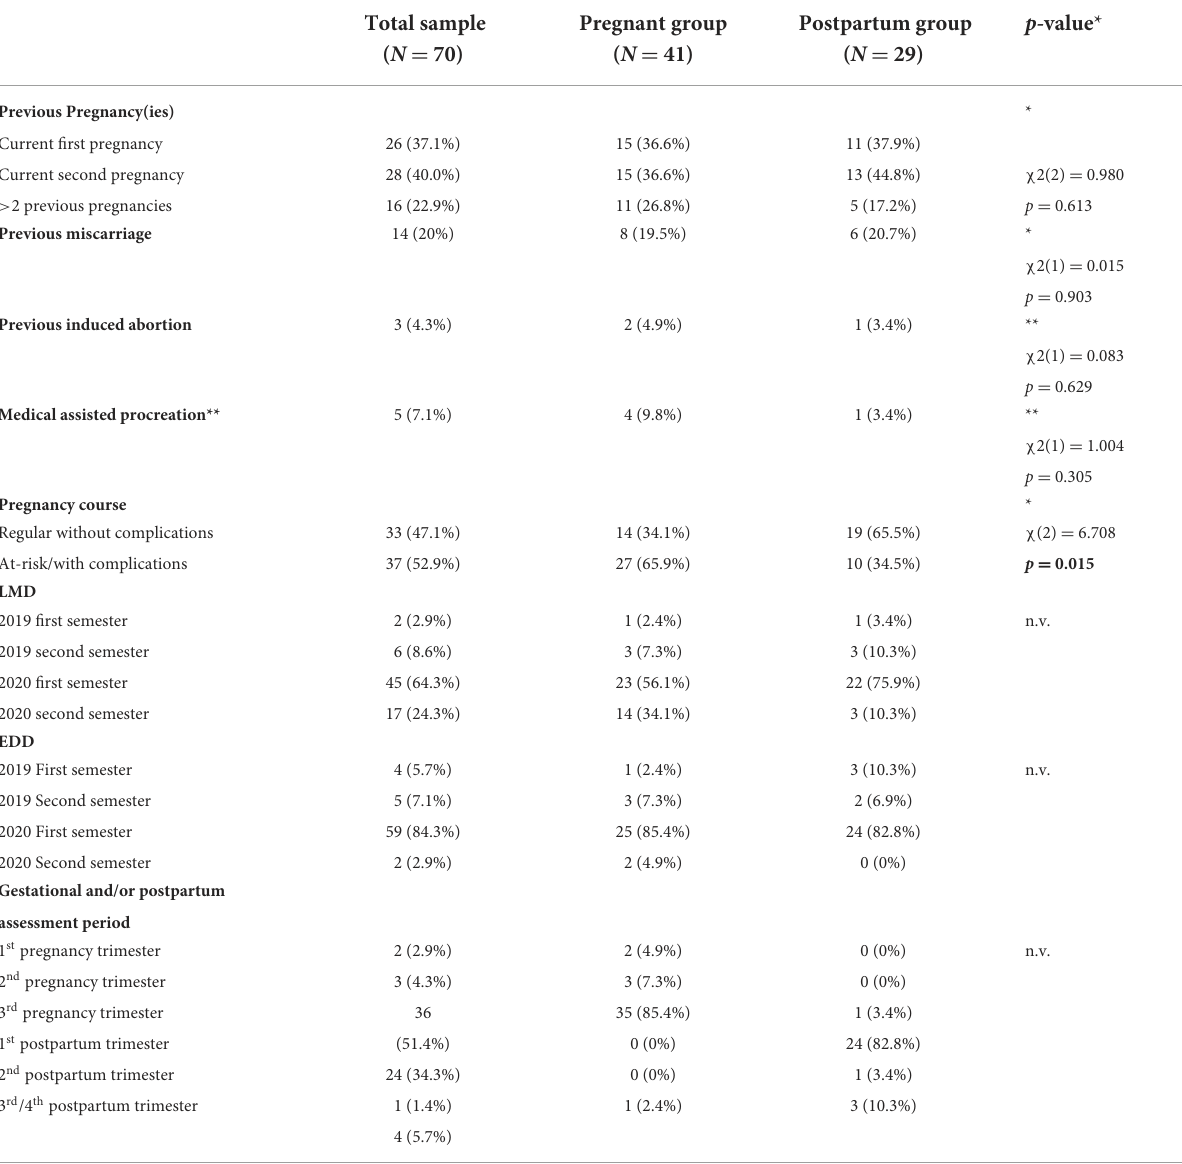
TABLE 2 Obstetric-gynaecological characteristics of the sample.